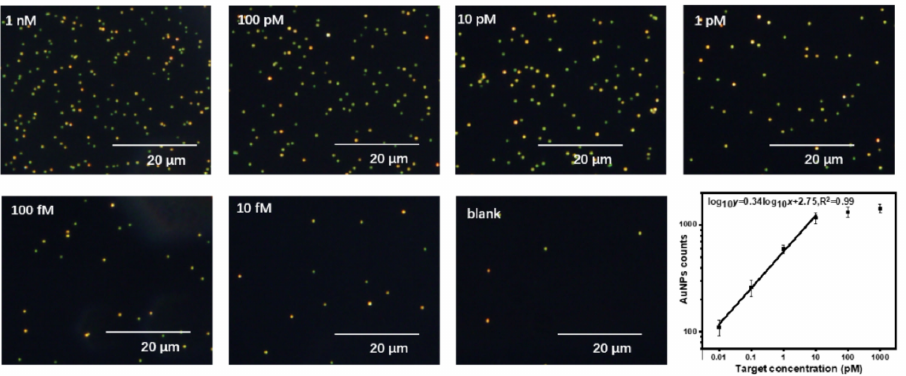
Figure 3. Dark-field images of Au nanoparticles and those obtained after different growth steps.